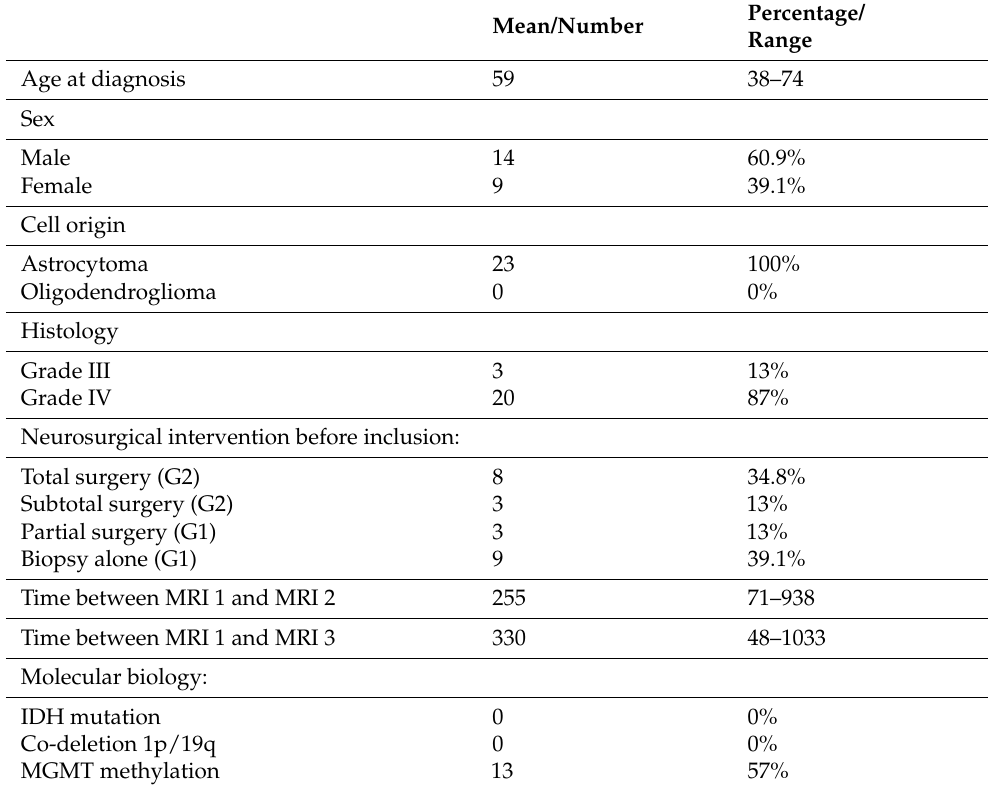
Table 1. Patient Table 1. Patient characteristics.